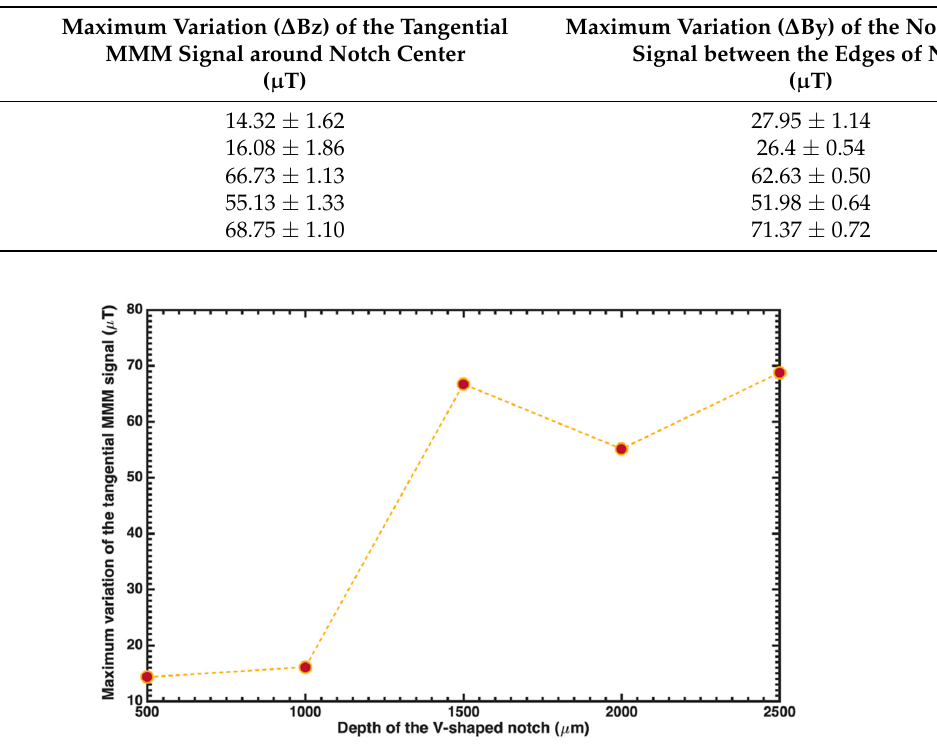
Figure 13. Maximum variation of tangential MMM signals versus depth of the V-shaped notch of the ASTM-A36 steel pipe.